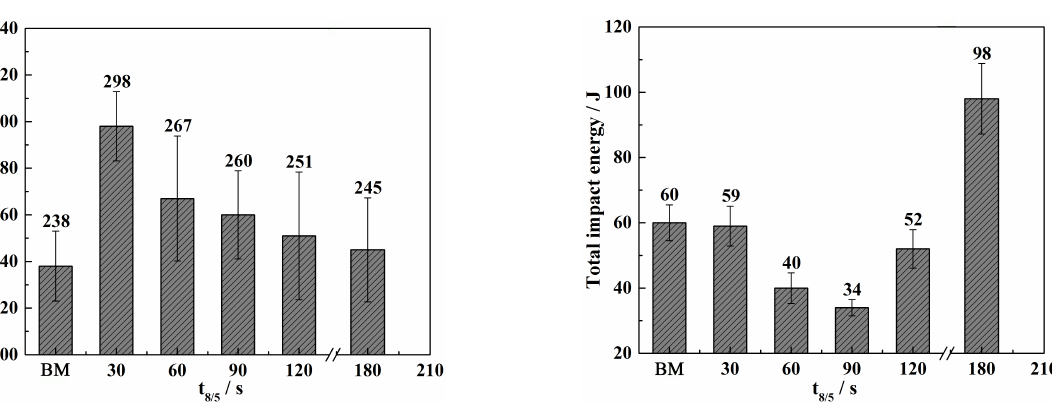
Figure 8: Total impact energy of the BM and the simulated CGHAZ versus t 8/5 (The error bars represent standard